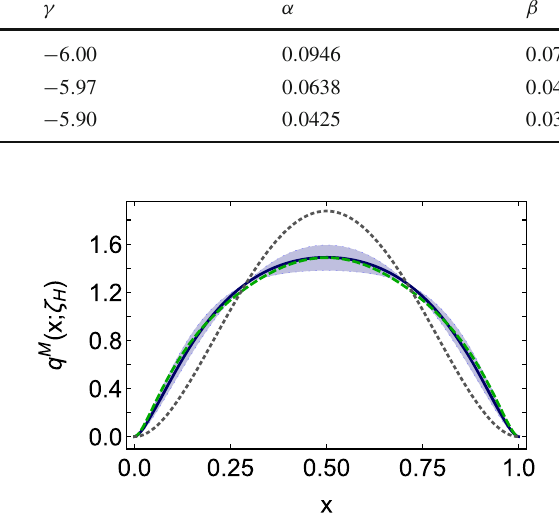
( x ; ζ ) , described by Eq.(45) and the “middle” Fig. 7 Kaon DA, ϕ u H K coefficients in Table 3 – solid blue curve. The associated band marks the domain bounded by the “upper” and “lower” coefficients in Table 3. ResultobtainedusingtheDBkernelinRef. [74]–dot-dashedredcurve. Pion DA in Eq.(28) – dashed green curve